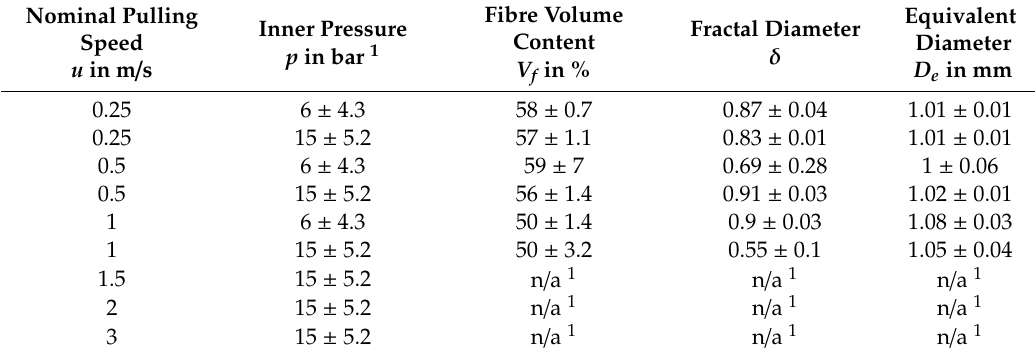
Table 3. Parameters of thermoplastic micro-pultrusion and analysis of semi-finished product’s resulting cross section for the pultrusion of polyamide PA6 with continuous glass fibre reinforcement (mean value ± standard